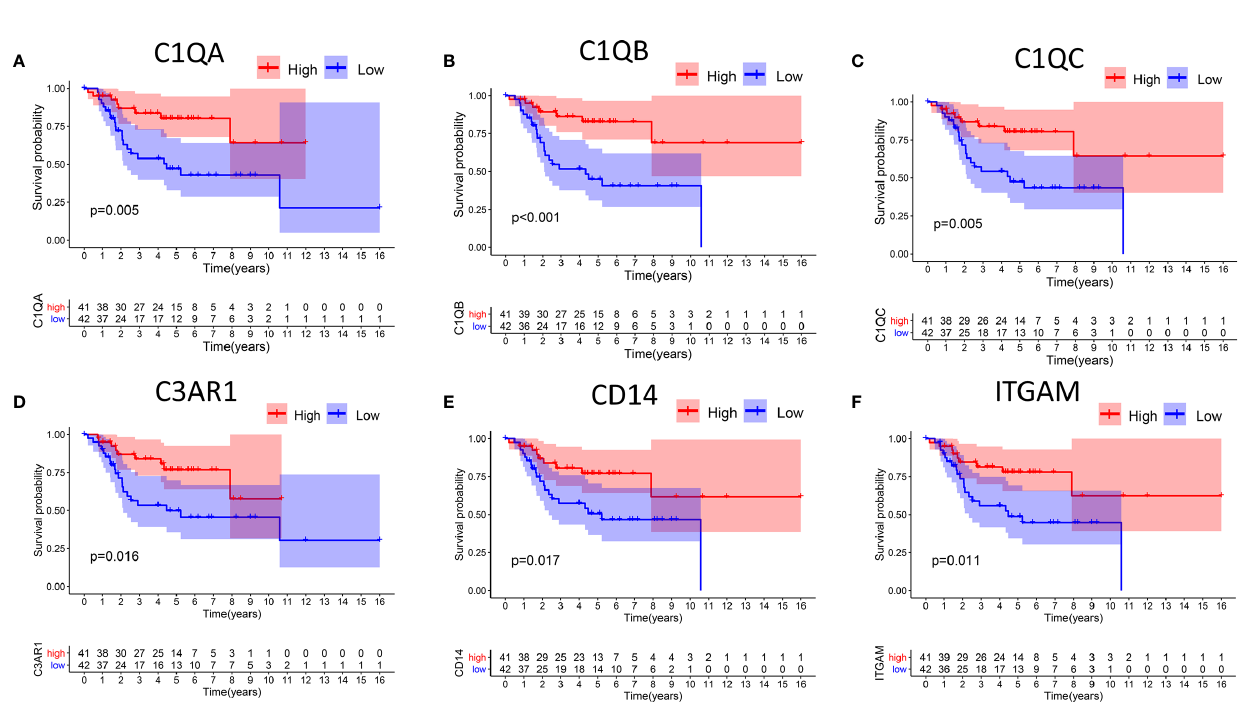
FIGURE 4 | Relationships between DEG expression and survival time in patients with OS. (A – F) Differences in survival between patients with high and low expression of DEGs. The high and low expression levels of DEGs in patients were de fi ned according to the median expression level. p < 0.05 (log-rank test) for all these